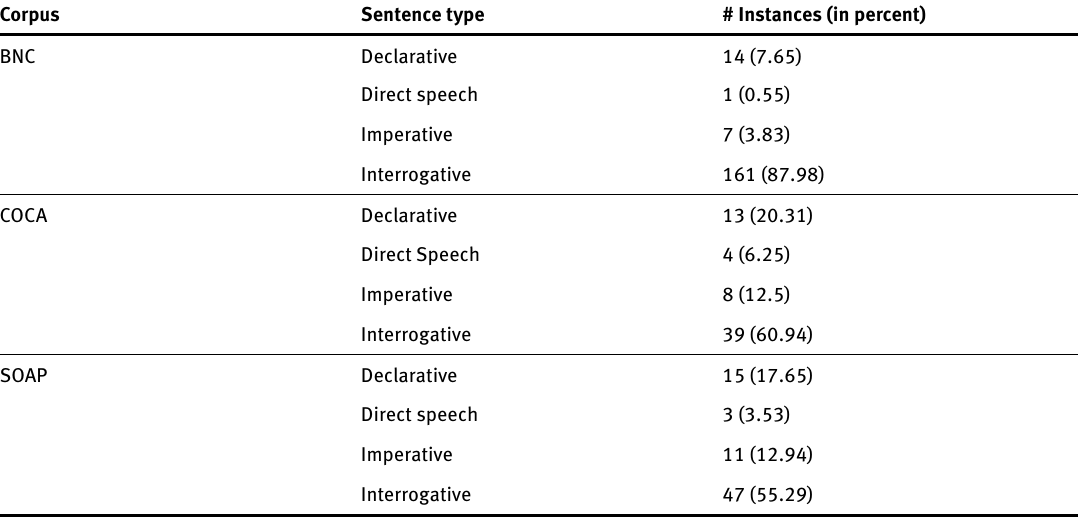
Table 3. Distribution of modal particle occurrences for final then by sentence type Corpus Sentence type # Instances (in